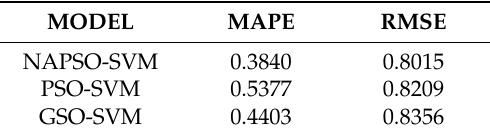
Table 3. Comparison of the index value among the three models (case 2).